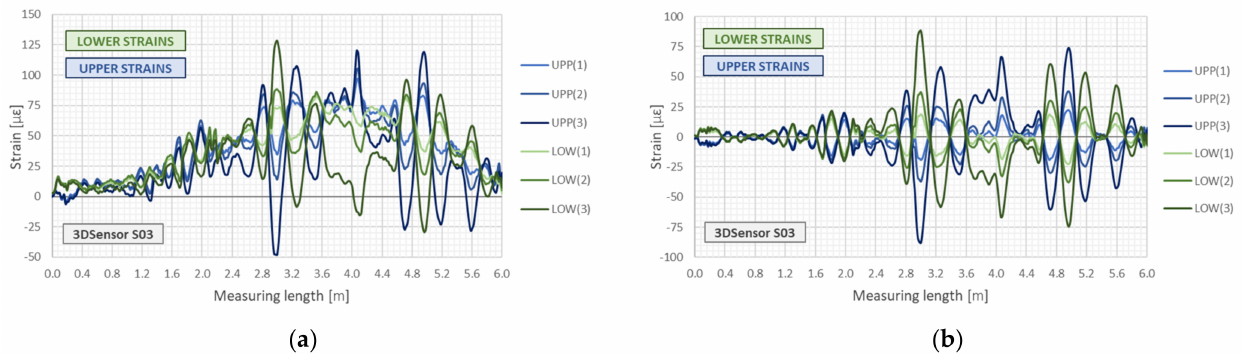
Figure 11. Example strain data from lower and upper fibres in the 3DSensor core for selected load steps 1–3: ( a ) raw data including the bending and the axial effects (force and temperature) [46]; ( b ) compensated due to the axial effects (including only bending) [46].